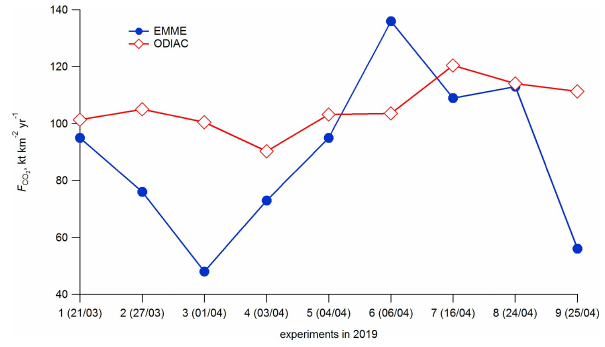
Figure 8. The CO 2 area flux ( F CO ) obtained on the basis of the 2 mass balance approach (EMME-2019) compared to the CO 2 area flux derived from scaled ODIAC data. The calculations are made for the trajectories shown in Fig. 7. Dots are connected by lines for illustrative purposes only.